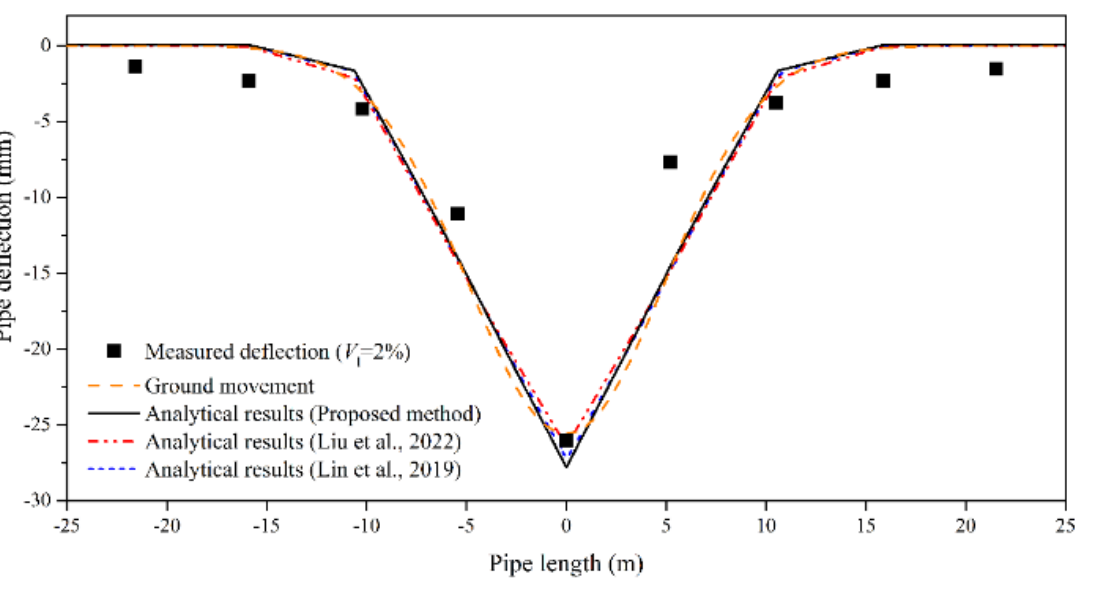
Figure 10. Verification and comparison for Test 2.